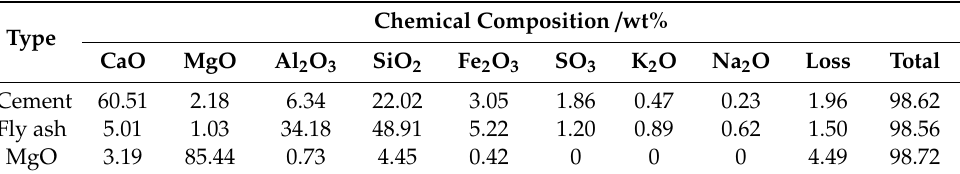
Figure 1. X-ray di ff raction pattern of MgO. Table 1. Chemical composition of cement.